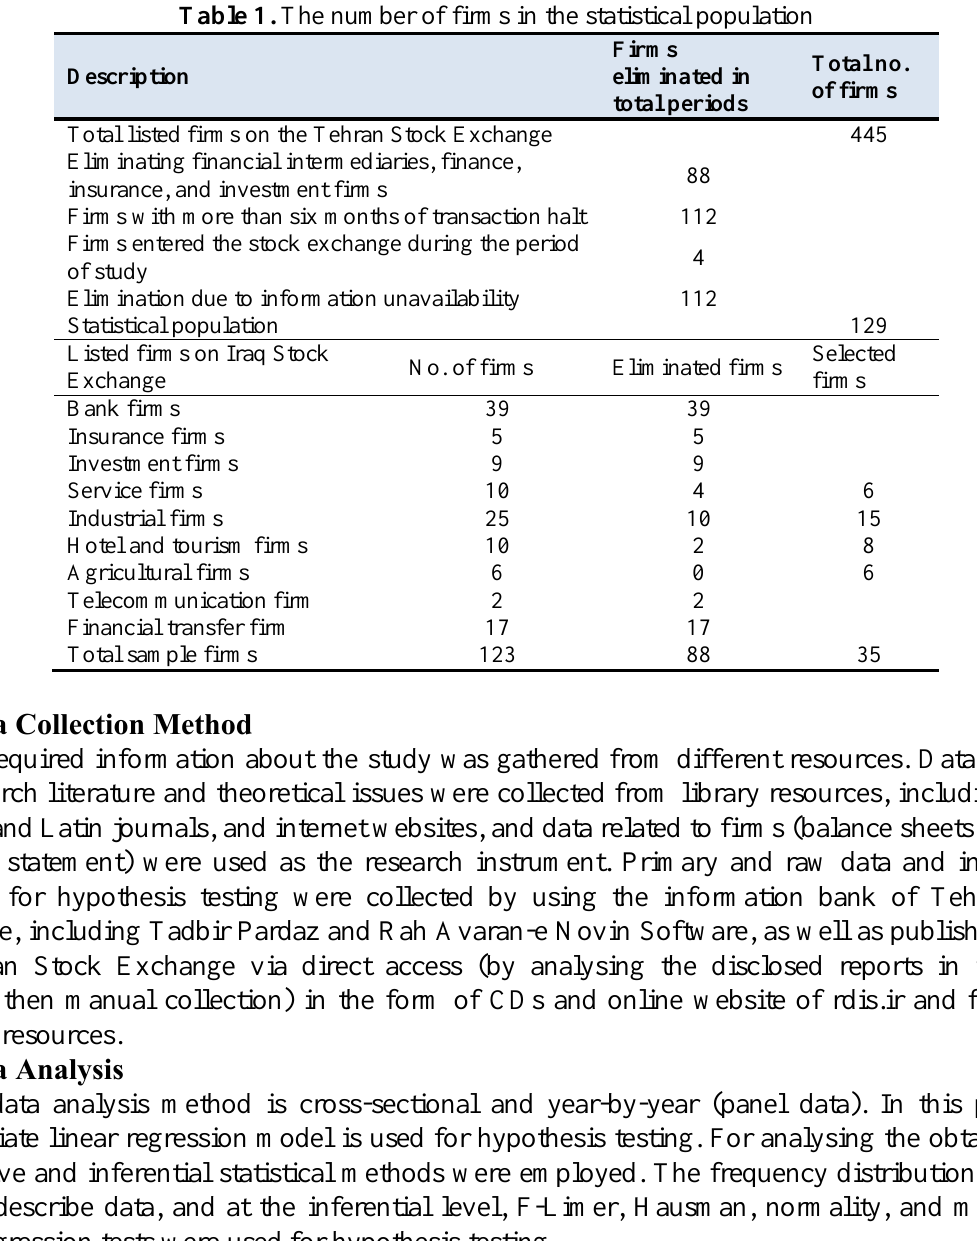
Table 1. The number of firms in the statistical population Description